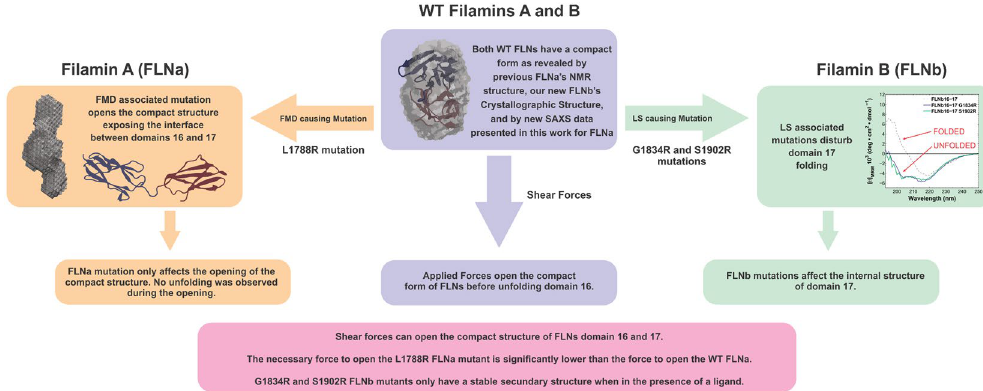
Figure 7. Schematic representation of effects of Skeletal Dysplasia mutations on FLN. In summary our results reveal that shear forces break a tight interaction between domains 16 and 17. Dysplasia associated mutations affect the structure of domains 16-17 either by destabilizing the internal structure of domain 17 or transforming 16-17 fragment from compact to an elongated